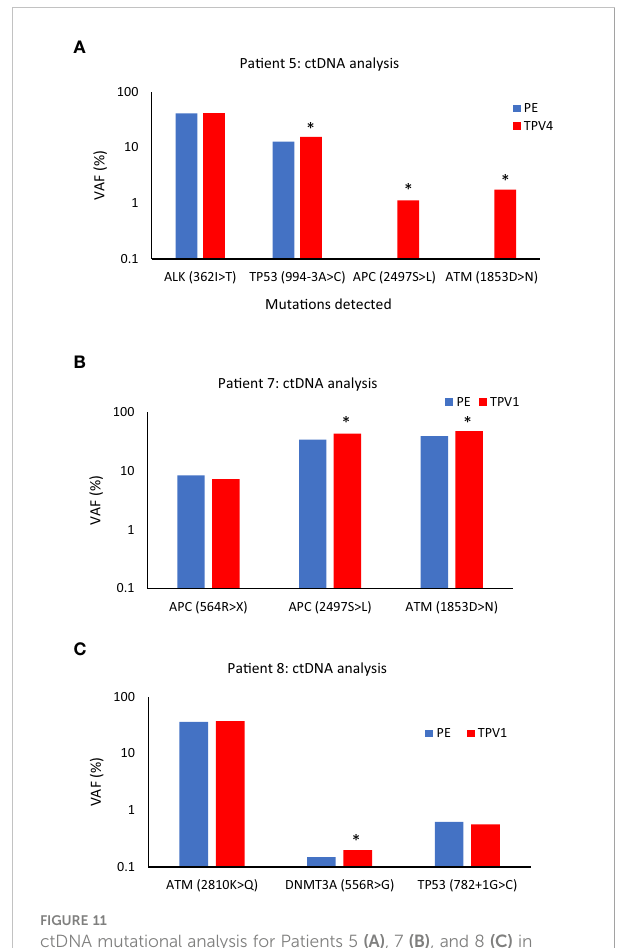
FIGURE 11 ctDNA mutational analysis for Patients 5 (A) , 7 (B) , and 8 (C) in peripheral versus tumor-draining/proximal veins. (A) Higher variant allele frequencies (VAFs) were seen for TP53 (994-3A>C), APC (2497S>L), and ATM (1853D>N) in the superior vena cava (SVC, TPV4) sample of Patient 5 ’ s neck mass compared to peripheral vein (PE) samples. (B) VAFs for APC (2497S>L), and ATM (1853D>N) were higher in the ctDNA from the middle hepatic vein 1 (MHV1, TPV1) sample of Patient 7 ’ s segment 8 lesion than a PE sample. (C) VAF for DNMT3A (556R>G) was higher in the anterior right hepatic vein (ARHV, TPV1) sample of Patient 8 ’ s segment 6 mass compared to PE. An asterisk (*) indicates increases in VAFs in TDV/TPV samples over PE; it does not imply statistical signi fi cance. PE samples are in blue, and the TDV/TPV samples are in red. VAF – variant allele frequency. The y-axis is on a log